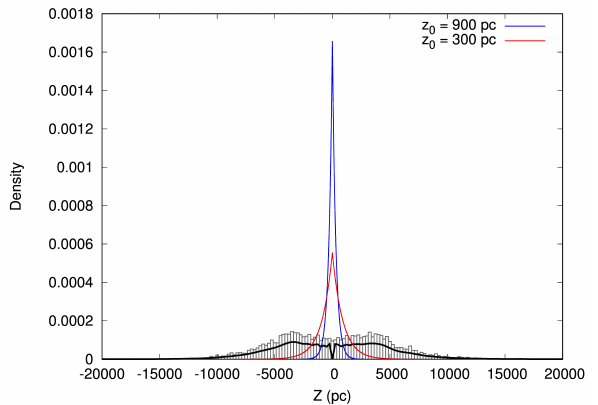
Figure 5. The distance to the disk of the stars classified as O, B and A, assuming a main sequence radius. The histogram is given as N / N total ; the solid black line is calculated assuming each point as a Gaussian with standard deviation of 0.1 Z. The red line is an exponential thin disk model assuming Z 0 = 300 pc, while the blue line is a thick disk model with Z 0 = 900 pc. All functions are normalised. It is clear that, if indeed main sequence objects, these stars are not consistent with a disk distribution, but would rather have to be in the halo.